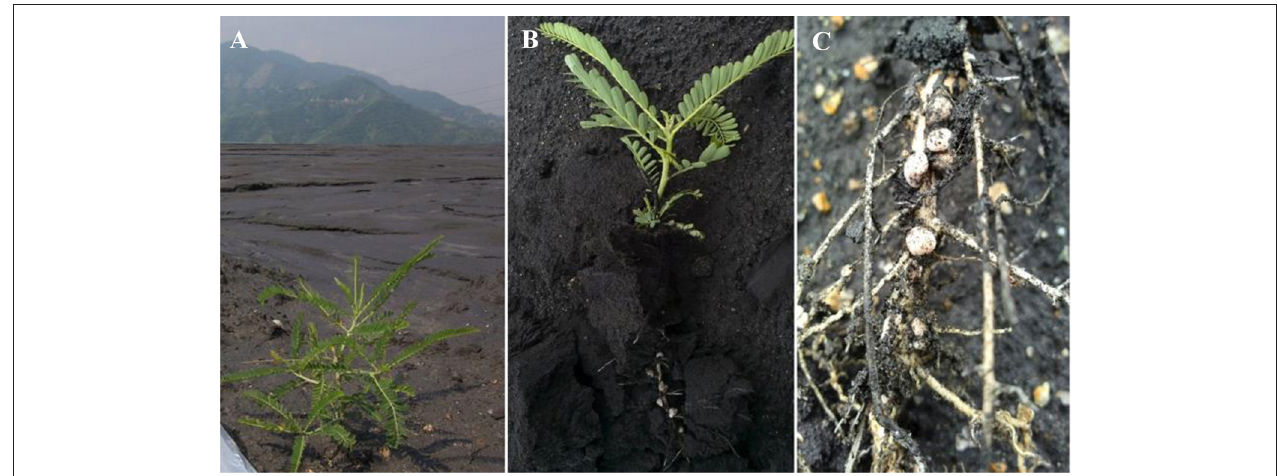
FIGURE 1 | (A) Sampling site at Majiatian V-Ti tailings reservoir in Panzhihua mining area and (B) a fresh plant sample of L. leucocephala with (C) vigorously growing root nodules thereon.